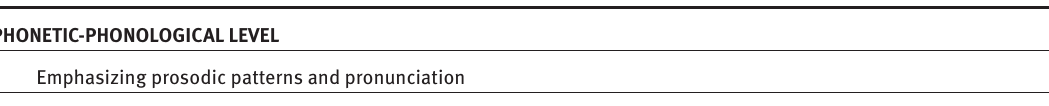
Table 1: Linguistic resources that impact group inclusion and individual discrimination